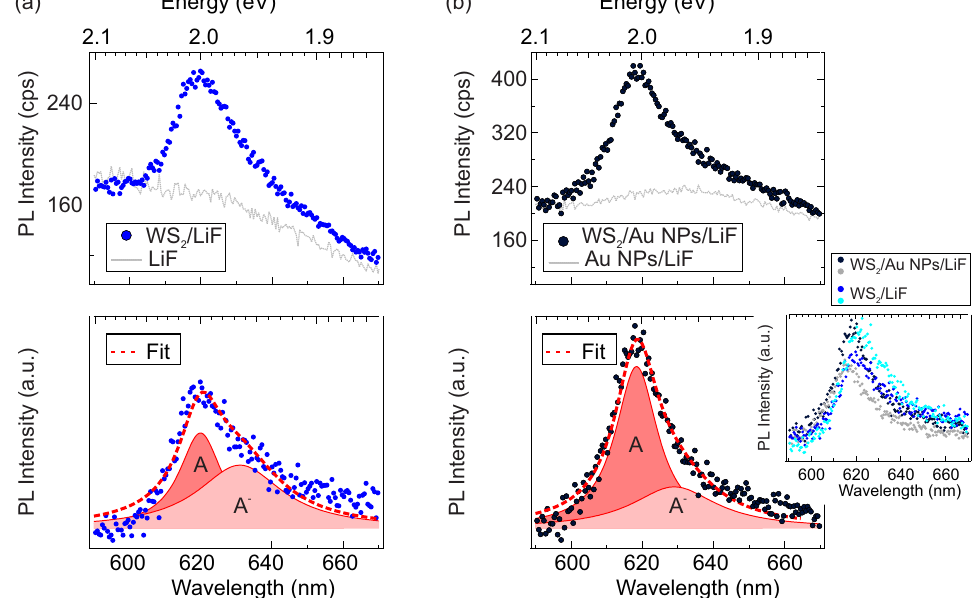
Figure A3. The top graphs show the PL spectra of ( a ) ML-WS 2 /LiF (blue circles) and ( b ) ML- WS 2 /Au NPs/LiF (black circles). The dotted grey curves correspond to the spectral response of the corresponding bare substrates, LiF and Au NPs/LiF, respectively. The bottom graphs report the deconvolution of the PL peak after having been normalized to the bare substrate. The PL spectrum is the sum of neutral (A, dark red) and charged (A − , light red) exciton contributions. The fitting curves are reported in dashed red. The inset shows some other PL spectra acquired from different spots of the WS 2 flakes on LiF (blue and light blue circles) and on Au NPs (black and grey